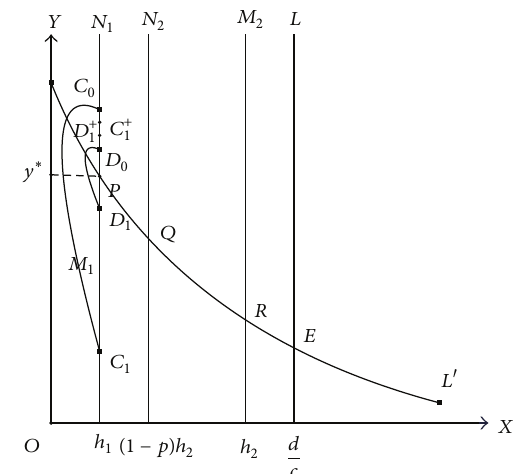
Figure 3: The structure graph of system (1).